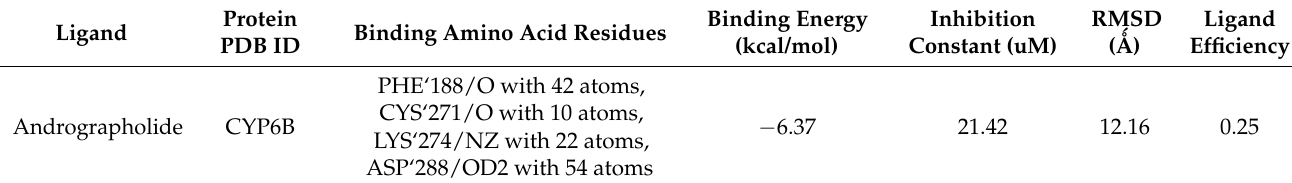
Figure 6. The ligand protein interaction of andrographolide with cytochrome P450 representing the binding pockets for the corresponding amino acid residues. Table 4. Docked amino acid residues of cytochrome P450 with andrographolide.